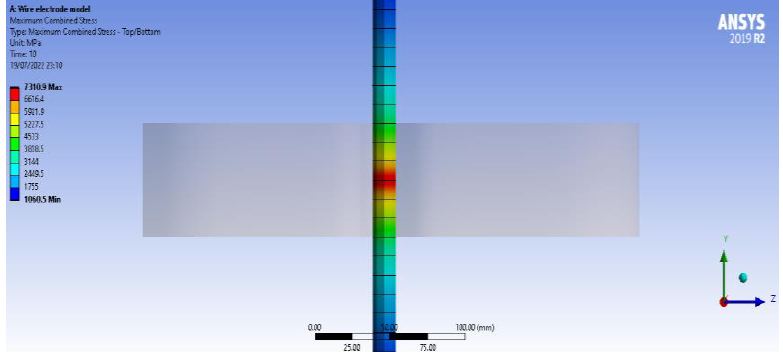
Figure 4. Stress in the wire electrode when it passes through the test sample due to the force gener- ated by the electrical